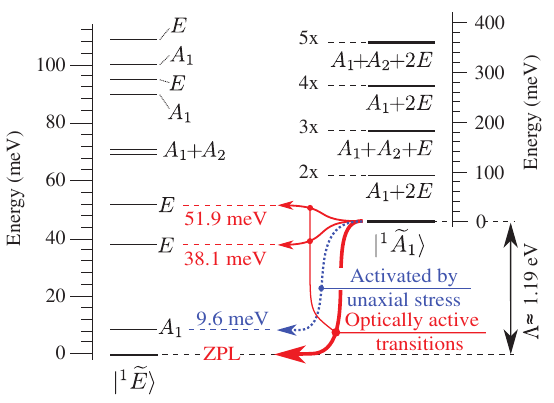
| A 1 | A is not scaled for the sake 1 + D JT JT